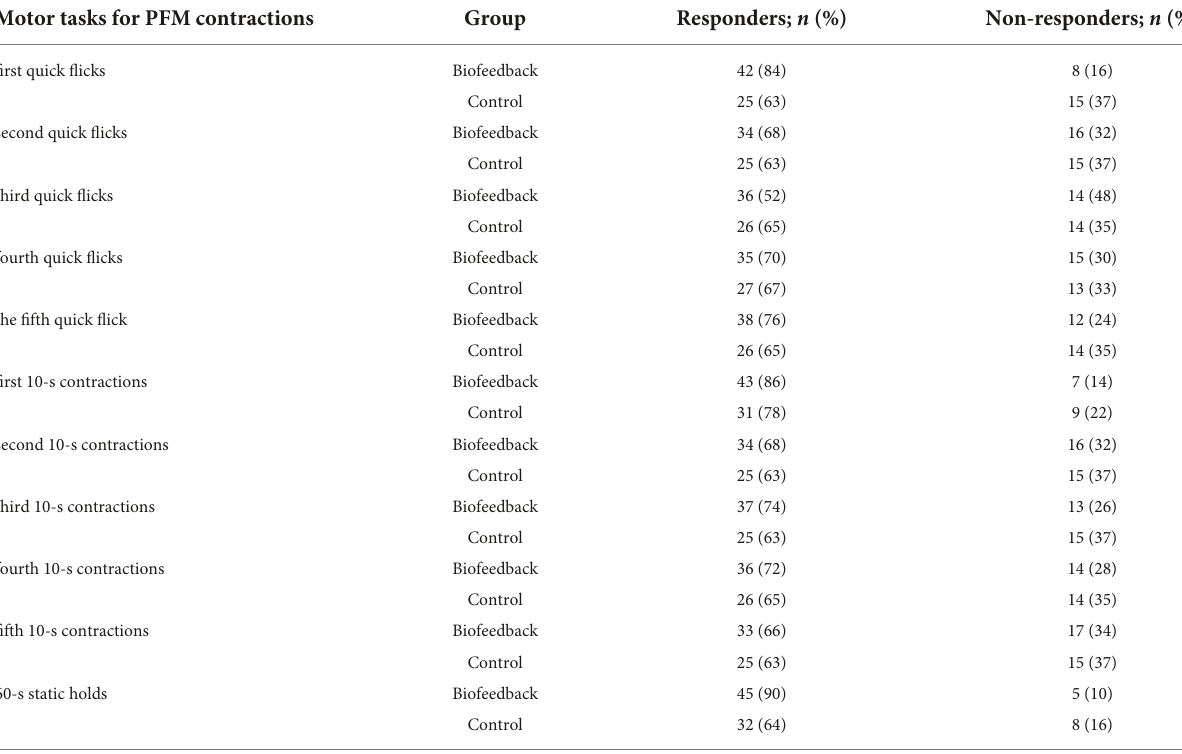
TABLE 3 The number of responders and non-responders in teaching pelvic floor muscles (PFM) contraction in a single surface electromyography (EMG) biofeedback session. Motor tasks for PFM contractions